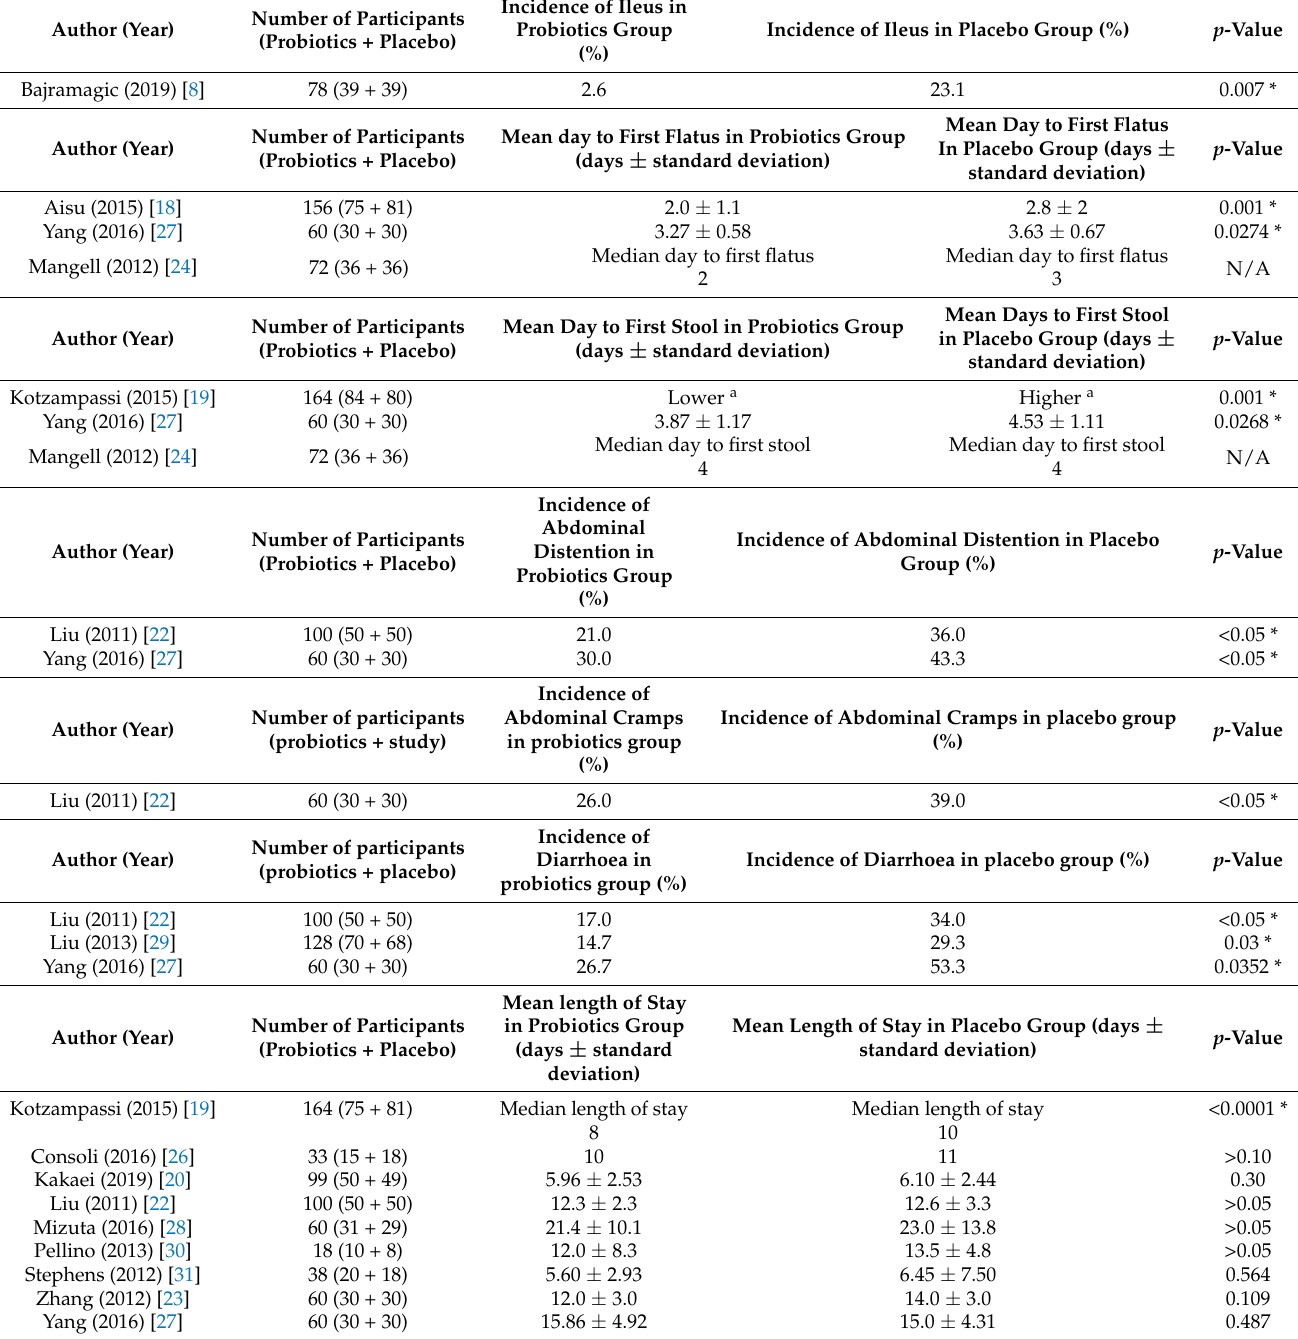
Table 3. Incidence of postoperative non-infectious complications and